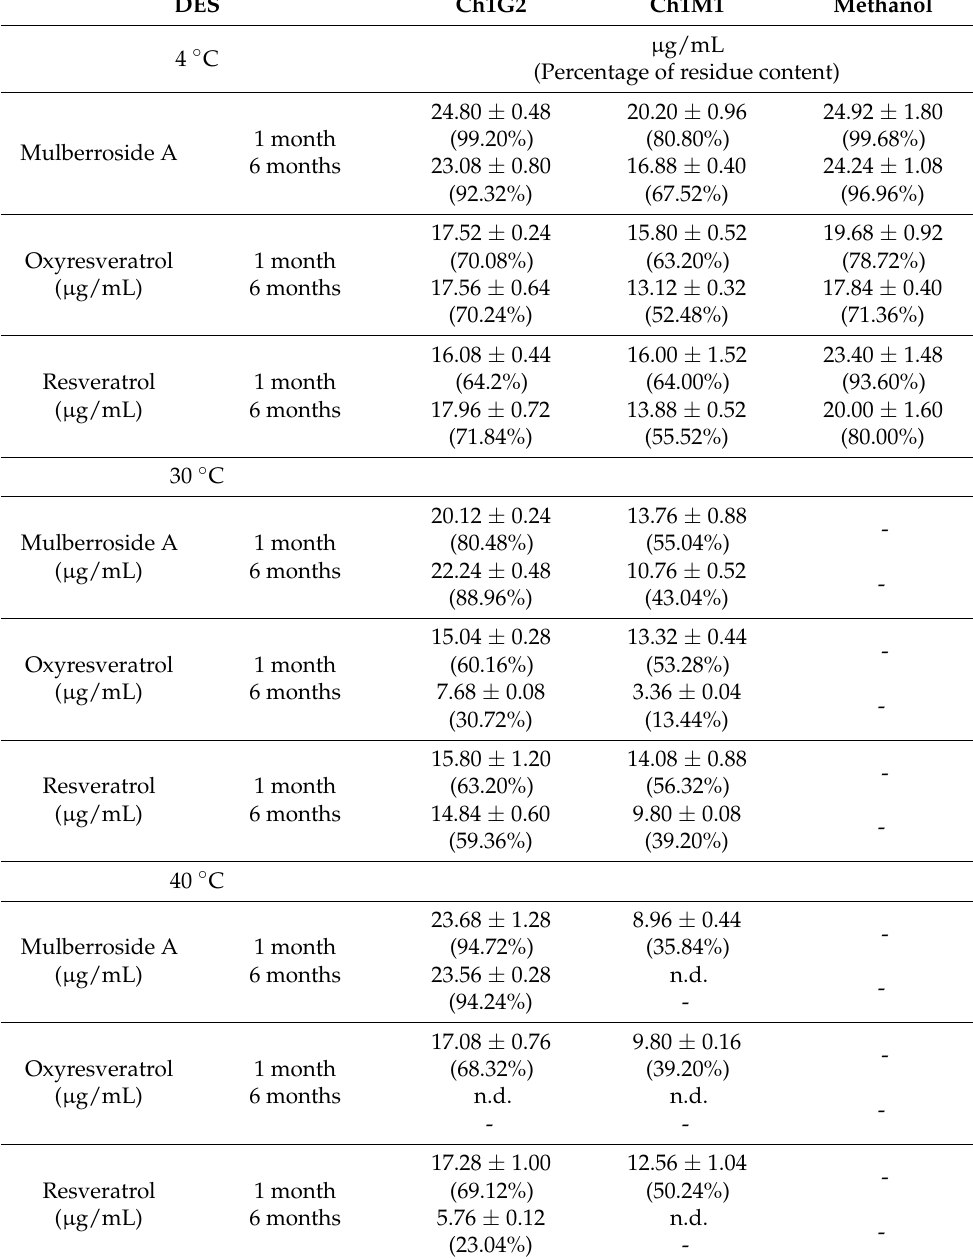
Table 4. The stability of added stilbenoids in NADES and methanol at varying temperatures for 1 and 6 months (mean ± SD, n =